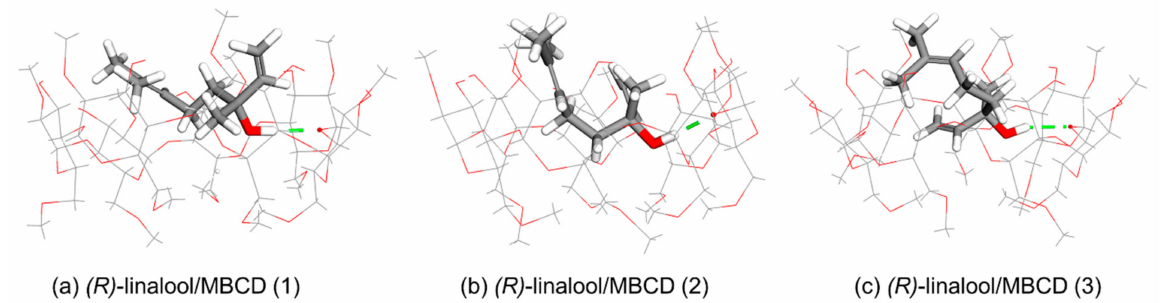
Figure 8. Energy-minimized structure of the 1:1 ( R )-linalool/MBCD complexes from three clusters using PM7 method. MBCD is presented as a line model. The linalool molecule is presented as a stick model. The green dashed line refers to hydrogen bond.